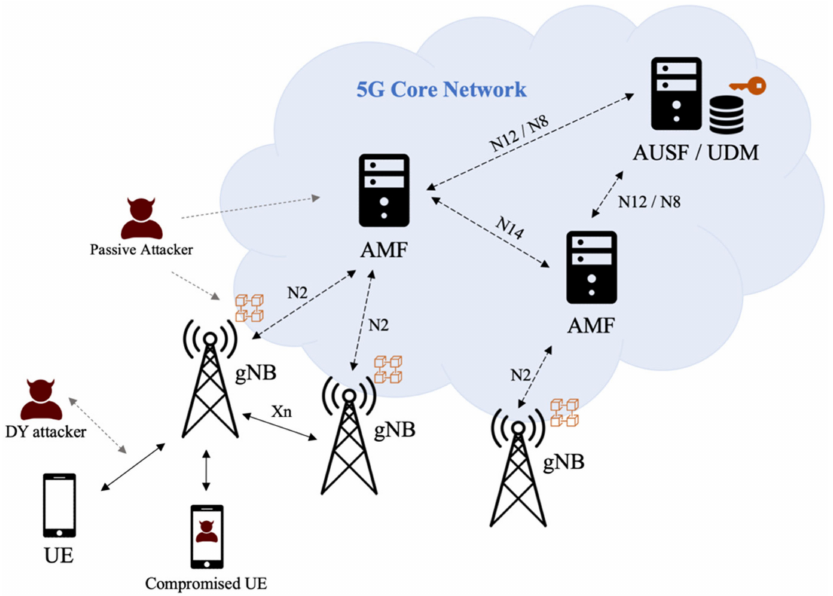
Figure 1. System and security